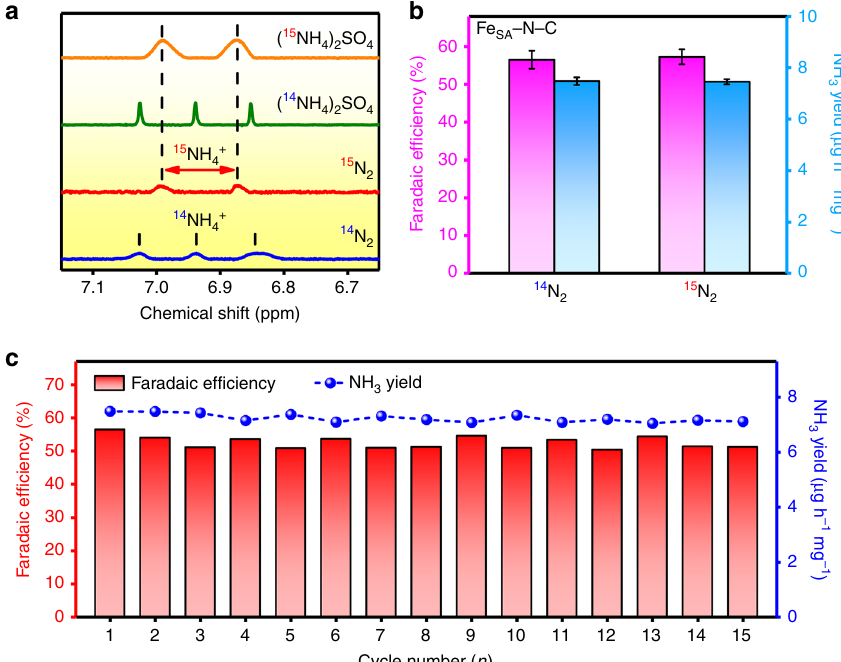
Fig. 3 15 N isotope labeling experiment and stability test. a 15 N isotope labeling experiment. b Comparison of the Faradaic ef fi ciency and ammonia yield rate using different feeding gases for the NRR at 0 V vs. reversible hydrogen electrode (RHE). The error bars correspond to the standard deviations of measurements over three separately prepared samples under the same conditions. c Faradaic ef fi ciencies and NH 3 yield rates of the single-atom